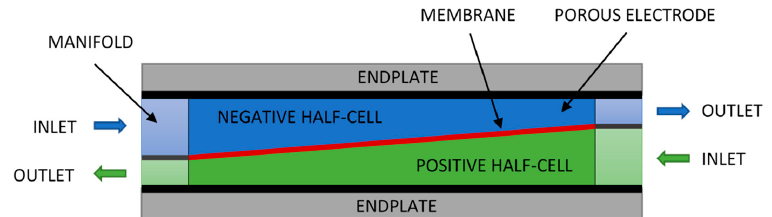
Figure 1. Single cell concept with proposed variable porous electrode compression in a counter-flow configuration allowing for standard endplates and bipolar electrodes. The separator or membrane is angled in this format.